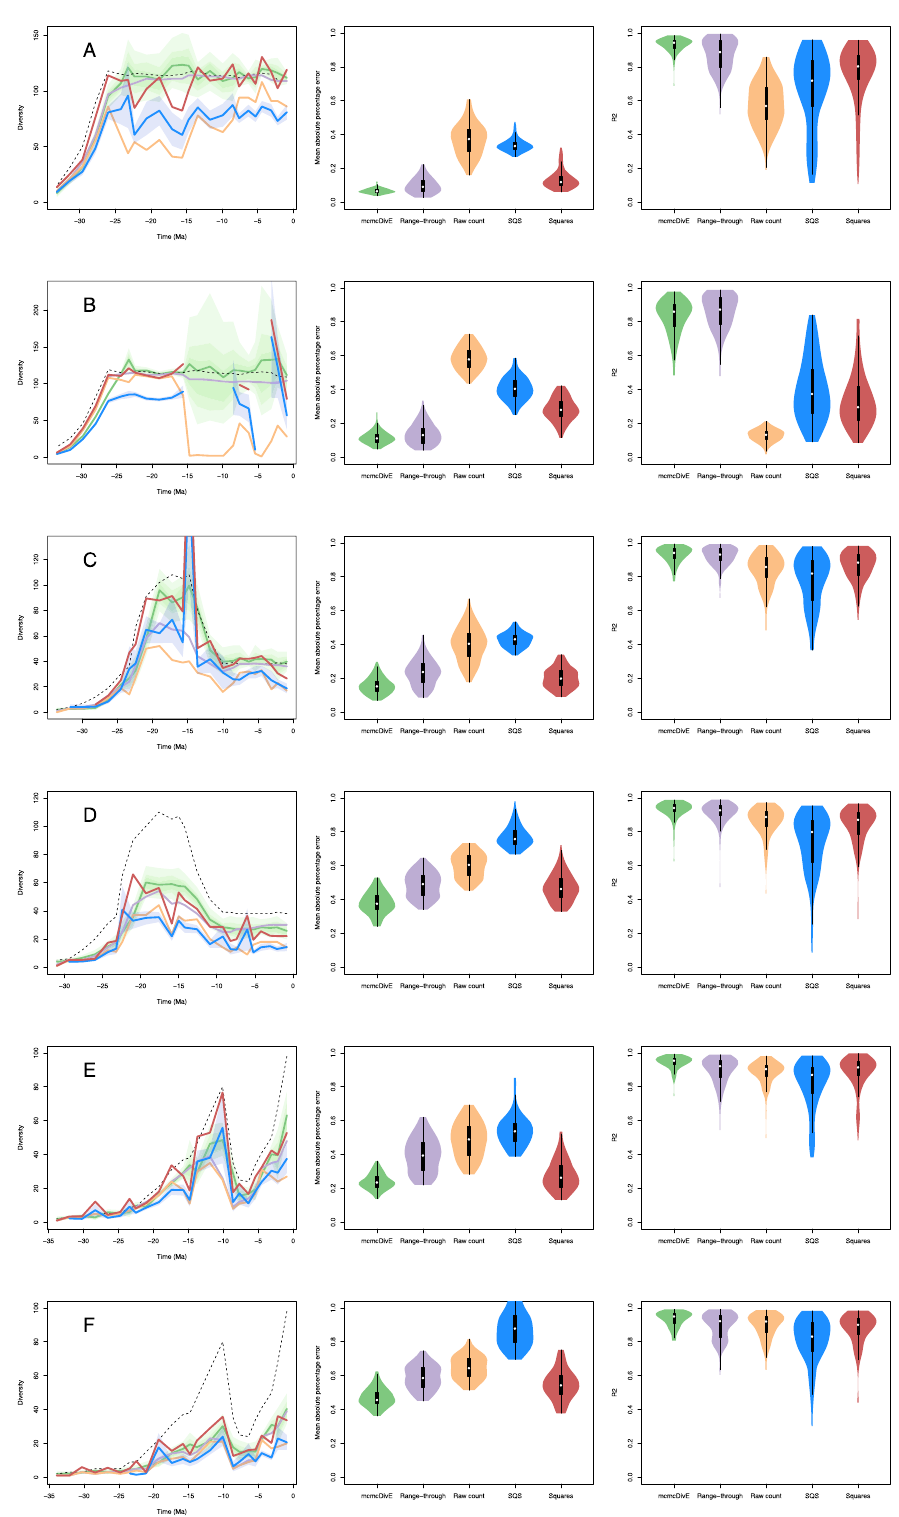
Fig. 9 Validation of mcmcDivE accuracy using six different birth-death preservation simulations. Plots in the left column show an example of diversity trajectories for one simulation: the true diversity is indicated with the dashed line, green line and shaded areas represent the mcmcDivE estimates and 95% con fi dence intervals. Purple, orange and red lines show the range-through, raw diversity and squares-extrapolated trajectories, respectively. Blue lines and shaded areas show diversity from coverage-based rarefaction/SQS and 95% con fi dence intervals. Violin plots show the distributions (range, 1st and 3rd quartiles and median) of absolute percentage errors and coef fi cient of determination between true and estimated diversity calculated from 100 simulations in each setting. The scenarios ( A – F ) refer to different birth-death and preservation settings as described in Table S65. Source data are provided as a Source Data fi